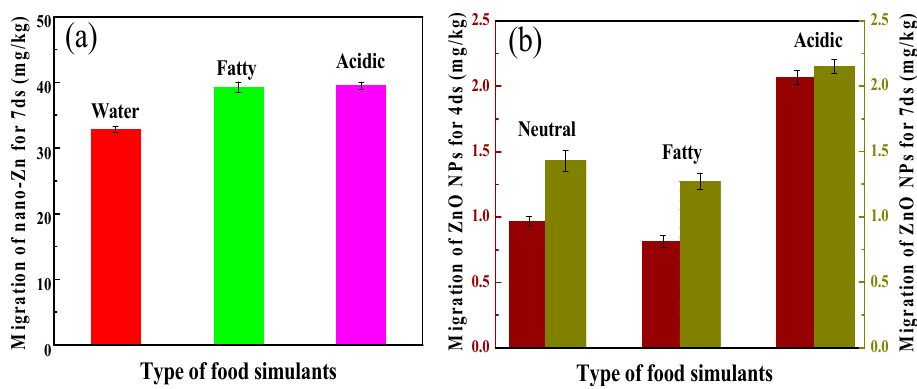
Figure 10. ( a ) Migration of ZnO NPs from films into different food simulants at 40 °C for four day; ( b ) migration of ZnO NPs from coated papers into different food simulants at 40 °C for four day and seven day.